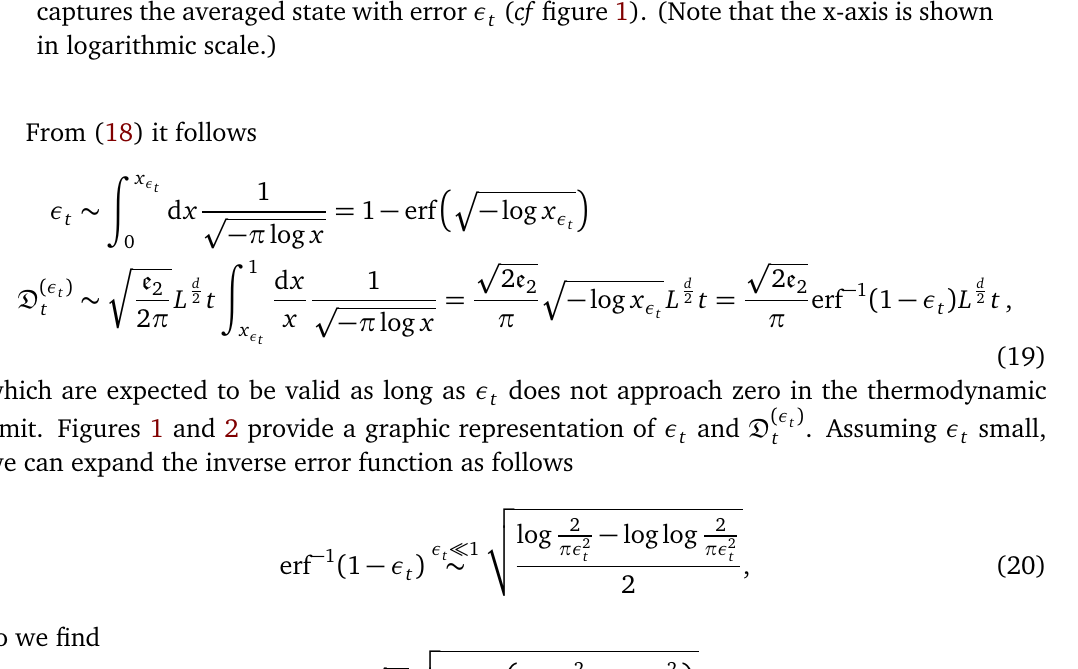
(cid:113) e ( ε ) d ( λ ) identifies a subspace that t 2 L , D 2 . The point ε t 2 π t ( cf figure 1). (Note that the x-axis is shown t